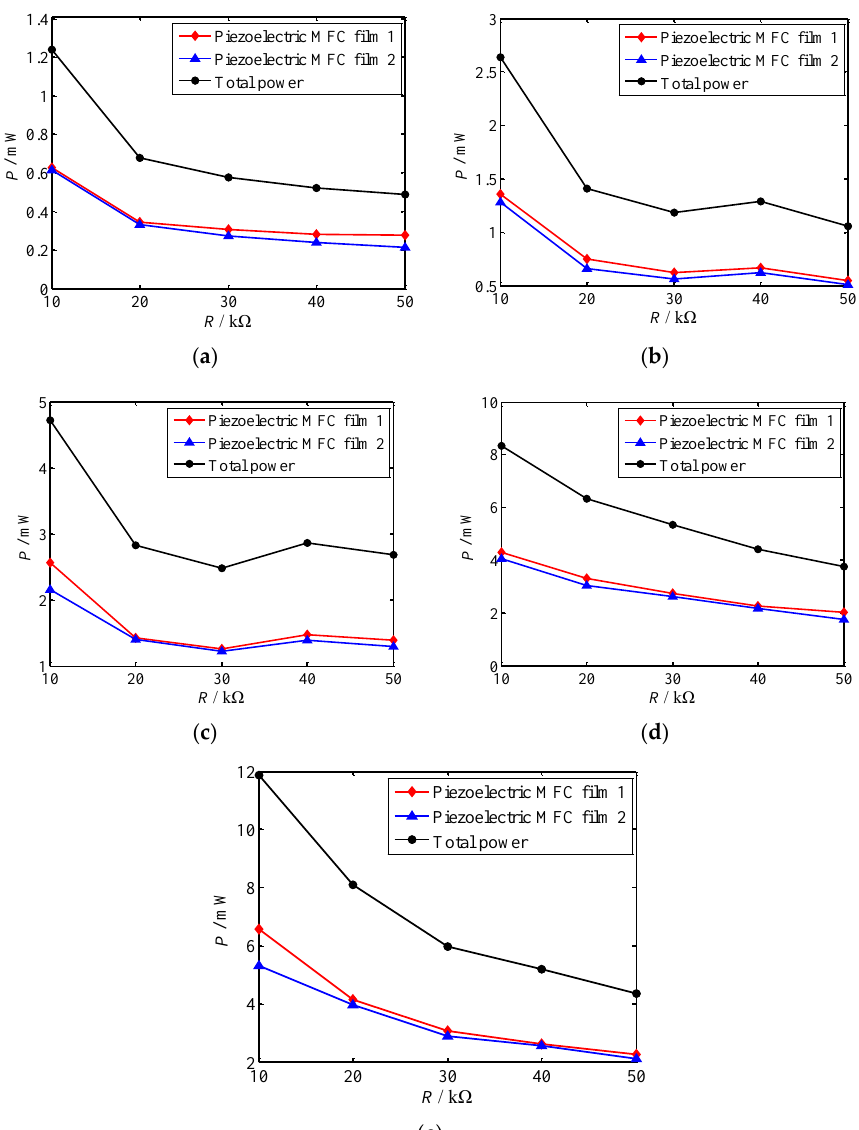
Figure 13. The output power varies with the load resistance under different excitation frequency. ( a ) f = 10 Hz; ( b ) f = 14 Hz; ( c ) f = 18 Hz; ( d ) f = 22 Hz; ( e ) f = 26 Hz.